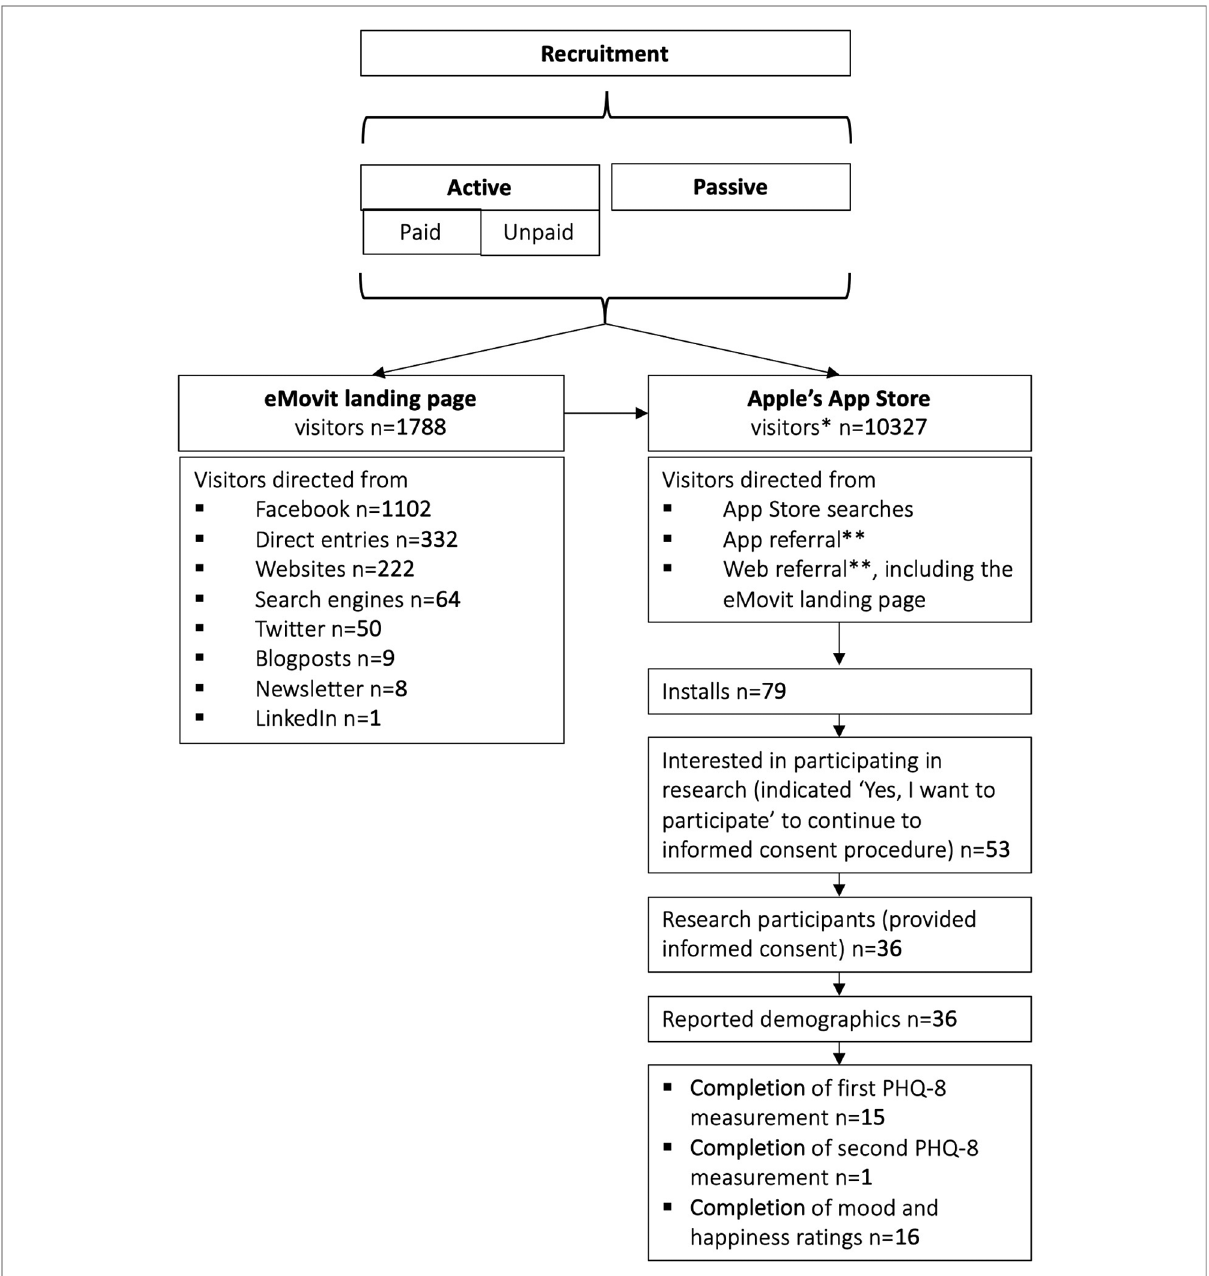
FIGURE 4 Participant fl ow. * visitors=app views ; ** app referral=visitors referred by another app; web referral=visitors referred by a